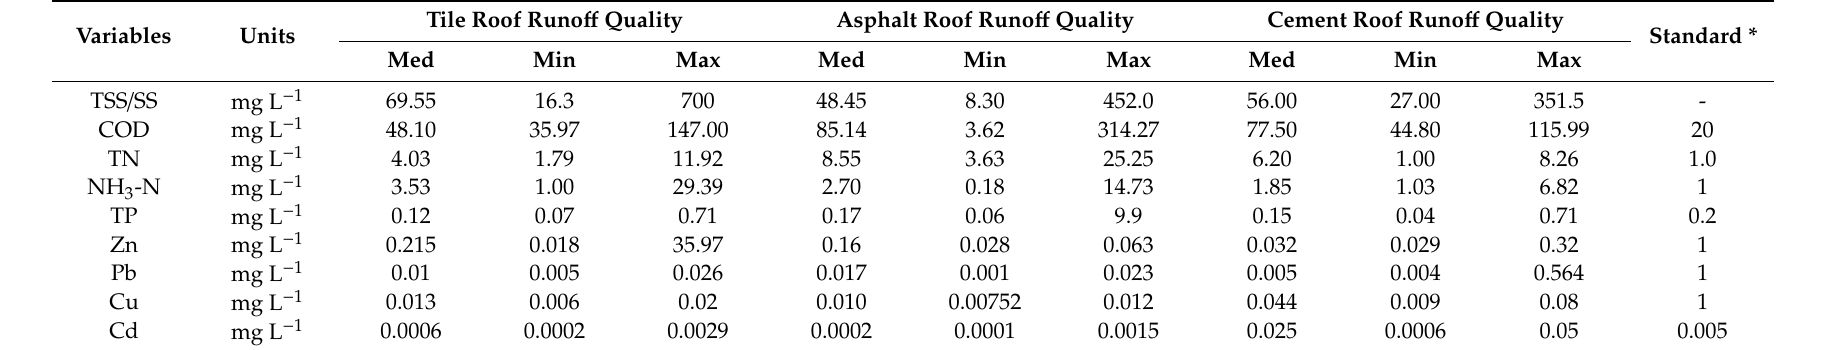
Table 7. Summary of physicochemical characteristic of roof stormwater